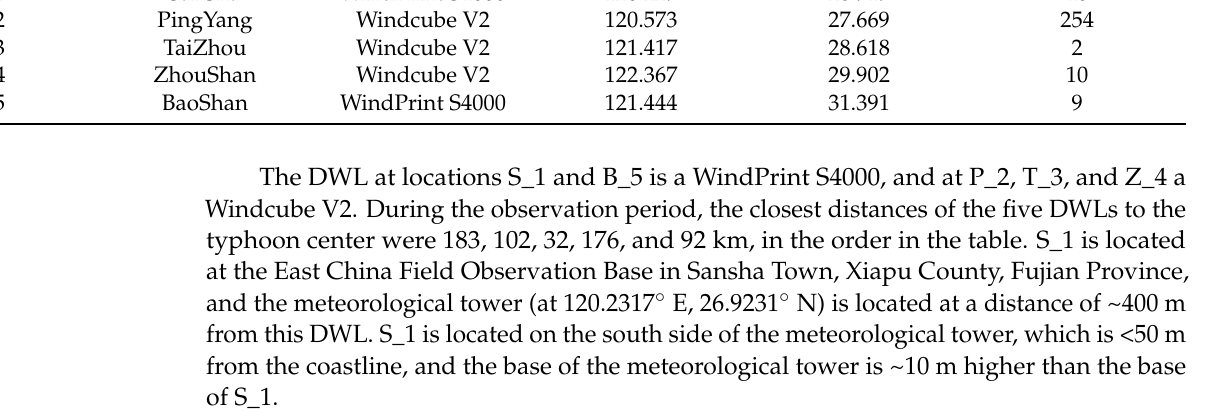
Table 1. Details of DWL type and location of the observation sites.